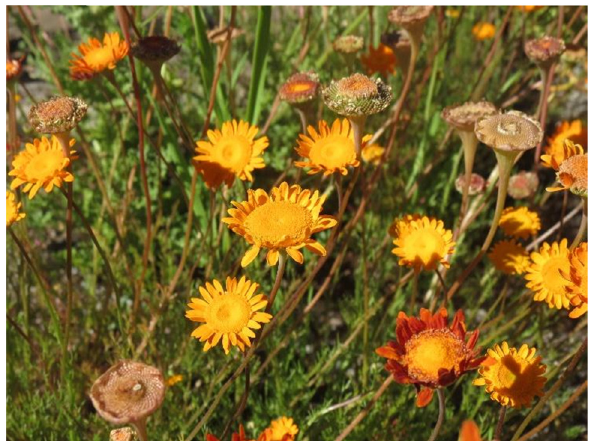
Figure 2: Cotula duckittiae ( Source: Roger Oliver ) . 30/9/2015: Kirstenbosch NBG 33.990574S